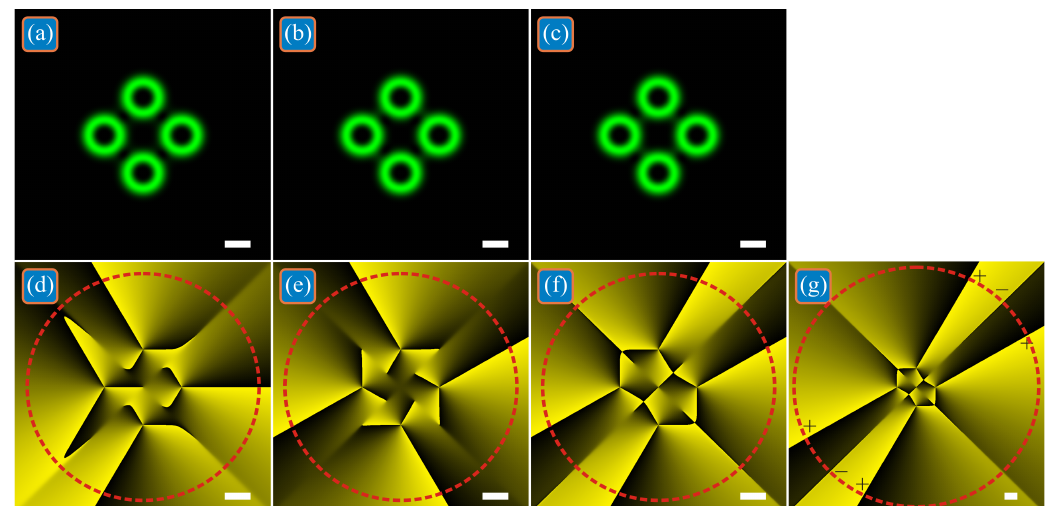
Figure 1. Intensities and phases of three superpositions of off-axis single-ring LG beams, in which the total TC is the same as that of each beam ( a , d ), or differs from the TC of each beam by +1 ( b , e ) and by −1( c , f , g ) due to the presence of complex weight coefficients in the superposition. Black and green intensity means zero and maximal values, respectively. Black and yellow phase means 0 and 2π, respectively. Here and in all other figures, red dashed circle on the phase distributions denotes the circle of the TC computation, whereas white scale marks in the right bottom denote 1 mm.